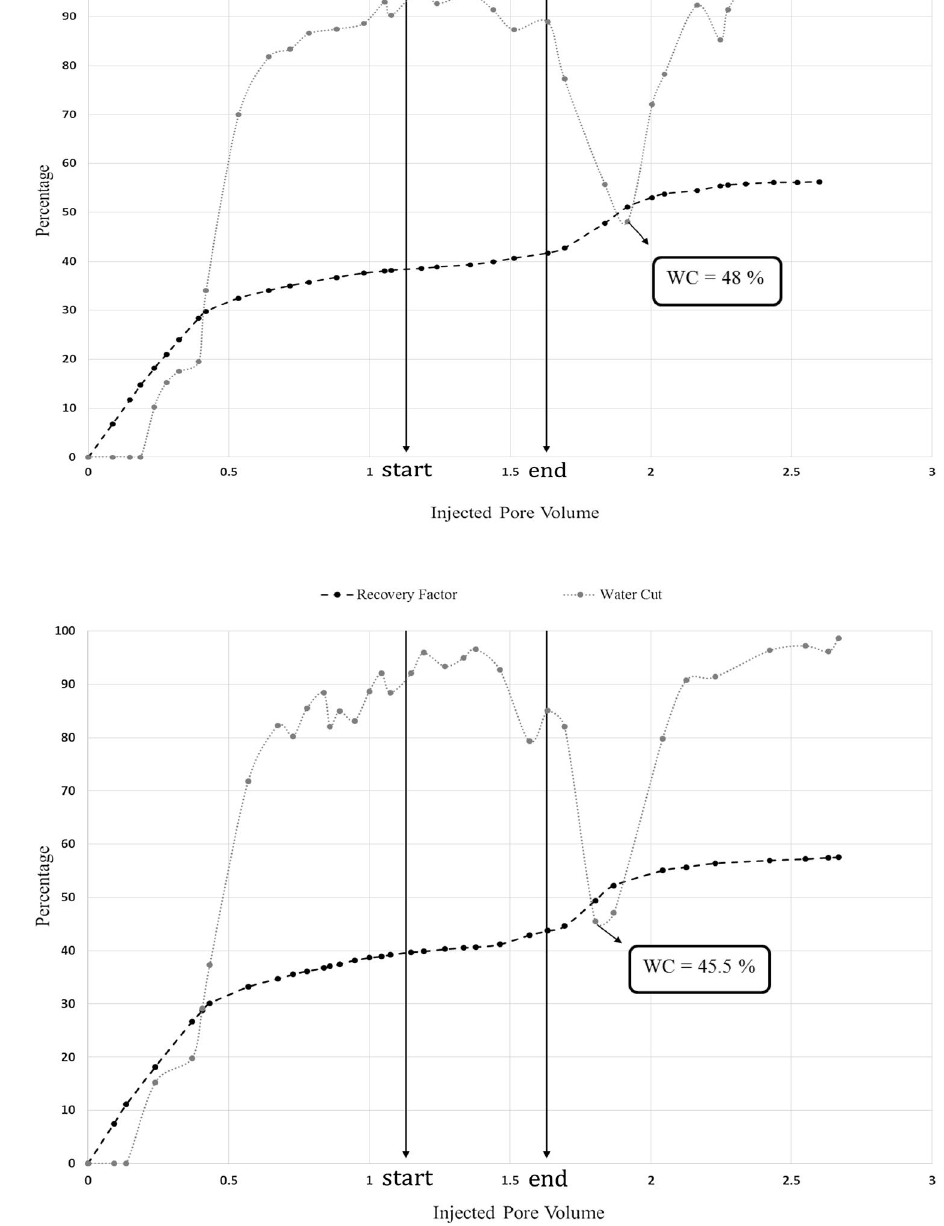
Fig. 6 Cumulative oil recovery and water cut during SW injec- tion and subsequent injection of emulsion 80/20 (test 3)